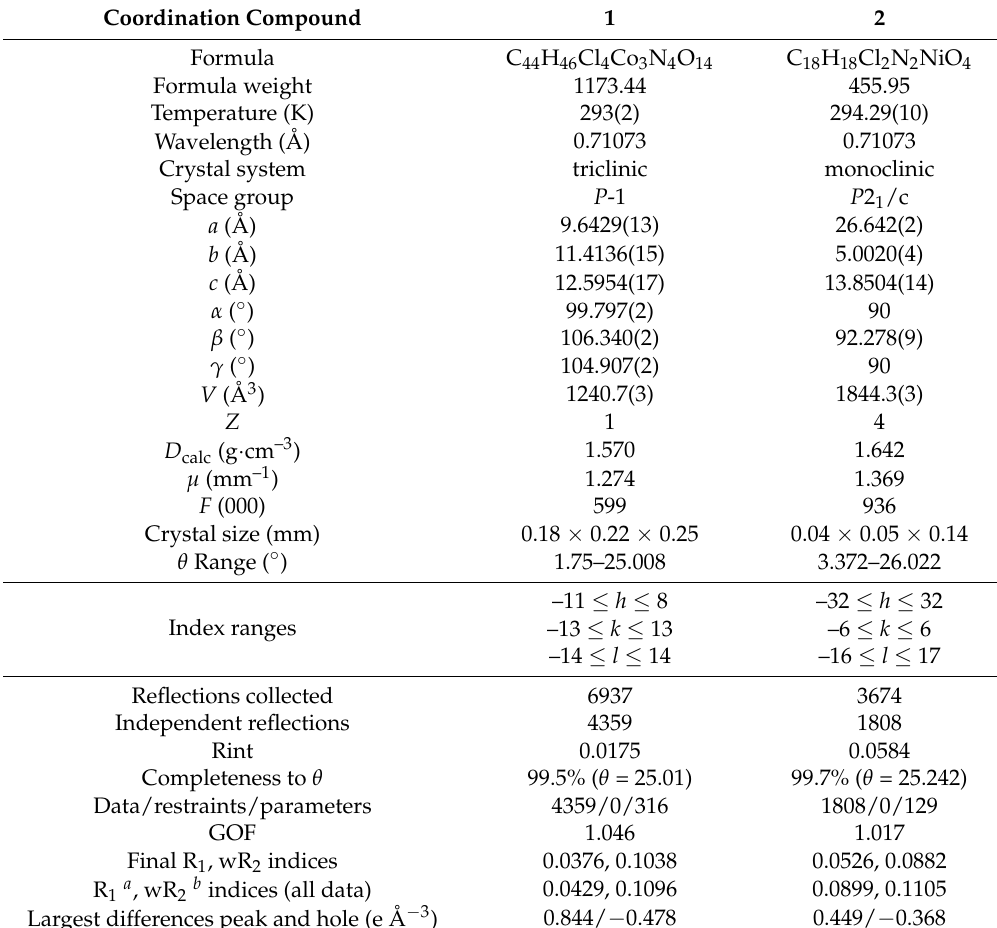
Table 1. Crystallographic data and refinement parameters for coordination compounds 1 and 2